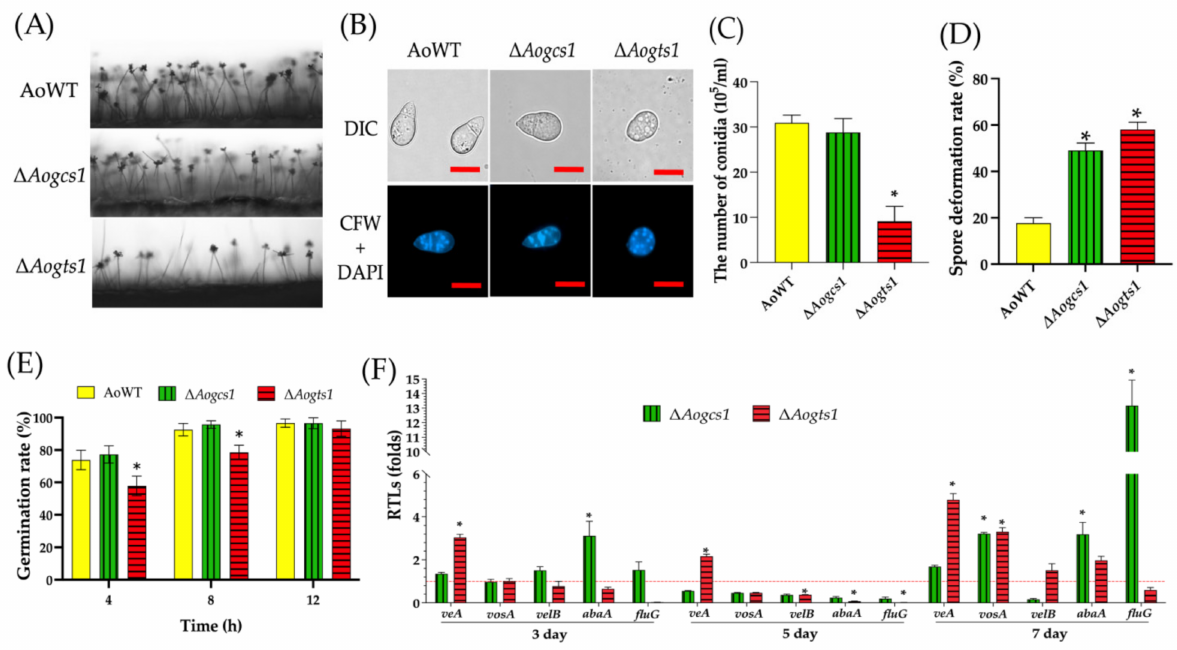
Figure 2. Comparison of conidiation, conidial germination, conidial morphology, and relative transcriptional levels (RTLs) of sporulation-related genes between WT and mutant strains of A. oligospora . ( A ) Sporulation in the WT and mutant strains; ( B ) conidia of WT and mutant strains were stained with CFW and DAPI (bar = 10 µ m); ( C ) comparison of conidial yields between the WT and mutant strains; ( D ) spore deformation rate of WT and mutant strains; ( E ) conidial germination rates in WT and mutant strains; ( F ) comparison of RTLs of sporulation-related genes in the mutant strain and WT strain at different time points. The red line indicates the standard (which has an RTL of 1) for statistical analysis of the RTL of each gene in a deletion mutant compared to that in the WT strain. The asterisk indicates a significant difference between the mutants and the WT strain (Tukey’s HSD, p <